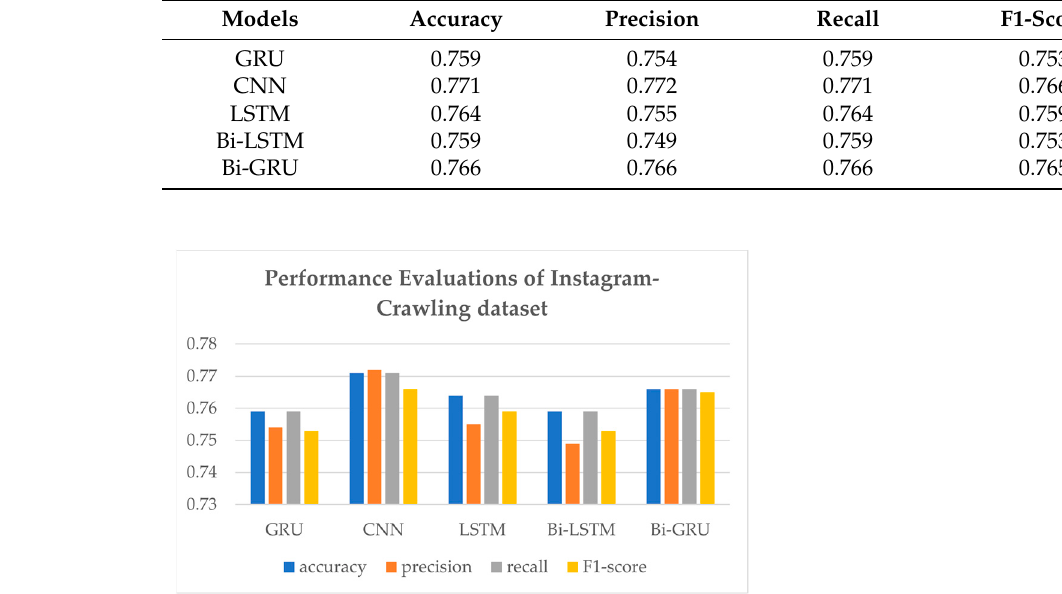
Figure 10. Bar table of evaluation performances of models.